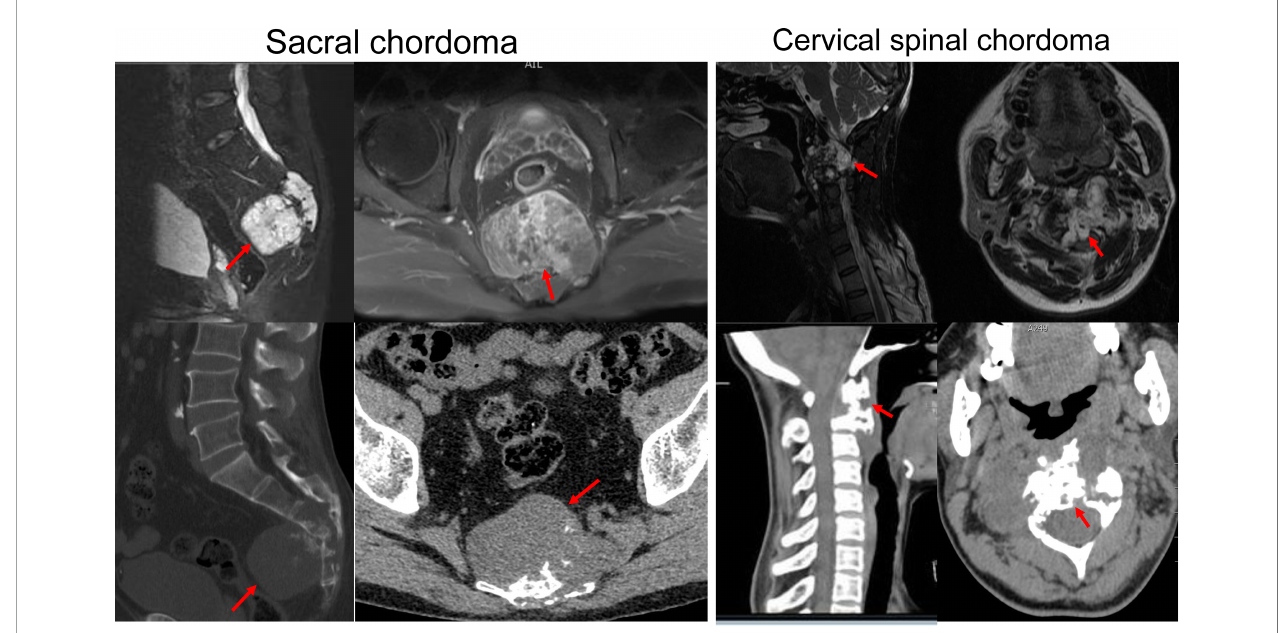
FIGURE 2 | Representative images of MRI and CT scan of sacral and cervical chordoma. The red arrows indicate the location of